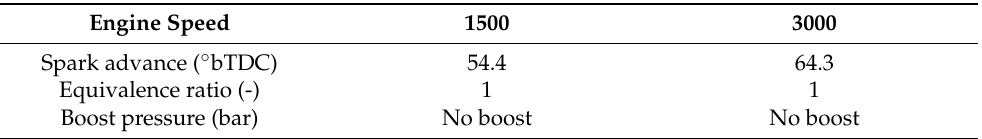
Table 5. Three-dimensional simulated points. WOT.